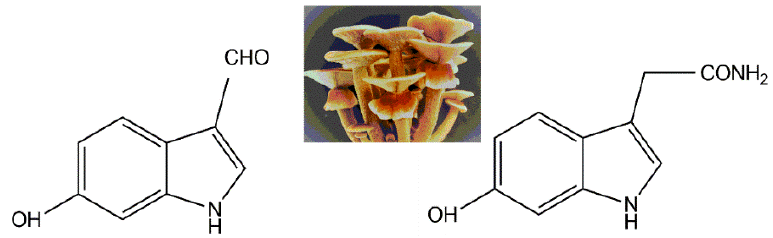
Figure 11. The indolic compounds 6-hydroxy-1H-indole-3-carboxaldehyde ( left ) and 6-hydroxy-1H-indole-3-acetamide ( right ) isolated from the fruiting bodies of Agrocybe cylindracea (middle, insert image).